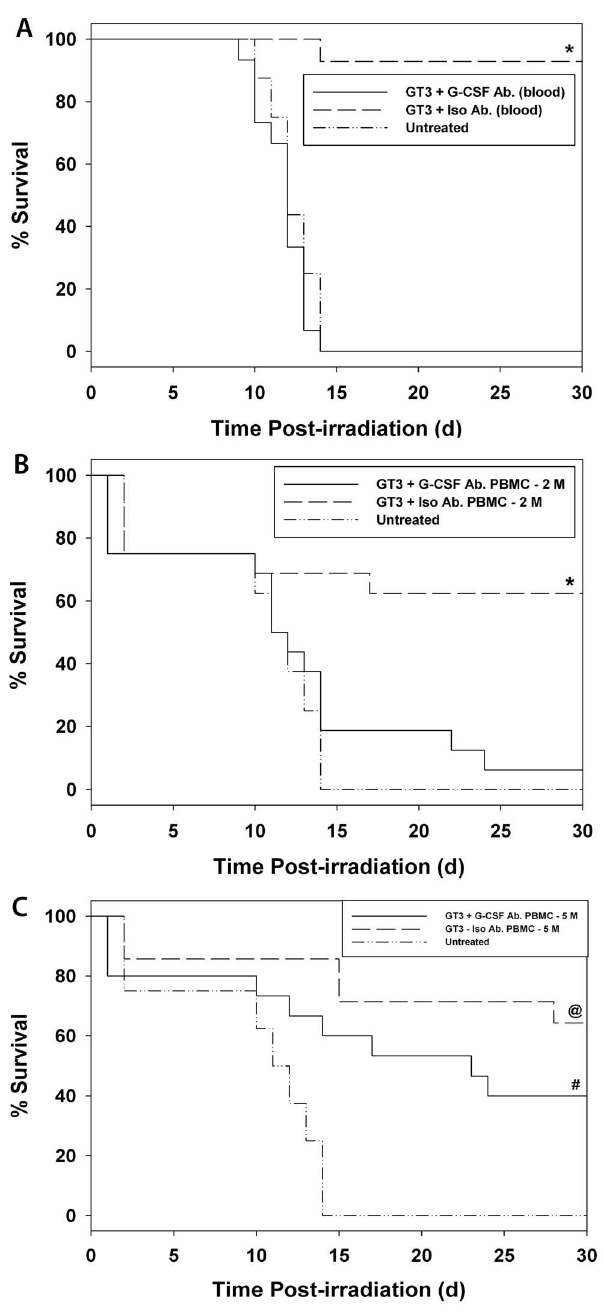
Figure 3. Evaluation of blood (A) or PBMC (B and C) from donor mice injected with GT3 and G-CSF antibody or isotype in irradiated mice. Donor mice were injected (sc) with 200 mg/kg of GT3, then G-CSF antibody or isotype (1,000 m g/mouse, ip) 8 h after GT3 injection. Blood was collected 64 h after G-CSF antibody/isotype injection. Recipient mice were injected 24 h after 11 Gy radiation exposure with A) whole blood, or B) 2 million cells or C) 5 million cells in 100 m l of PBS containing 1% FBS. *Denotes significant differences between recipients receiving cells from animals treated with isotype versus G-CSF antibody or untreated control groups (p , 0.01). @ Denotes significant difference between isotype-treated and untreated groups (p , 0.001). # Denotes significant difference between G-CSF antibody-treated and untreated groups (p 5